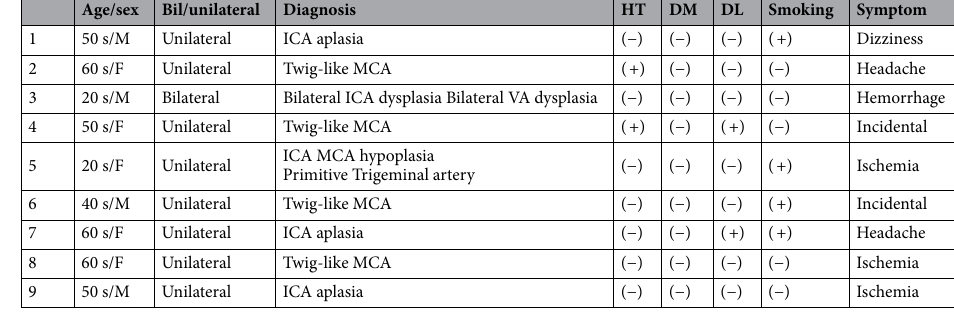
Table 1. Demographic and clinical characteristics of patients enrolled in the study. DL dyslipidemia, DM diabetes mellitus, F female, HT hypertension, ICA internal carotid artery, M male, MCA middle cerebral artery, VA vertebral artery. Age, age at admission. Case 1 was diagnosed at 9 years